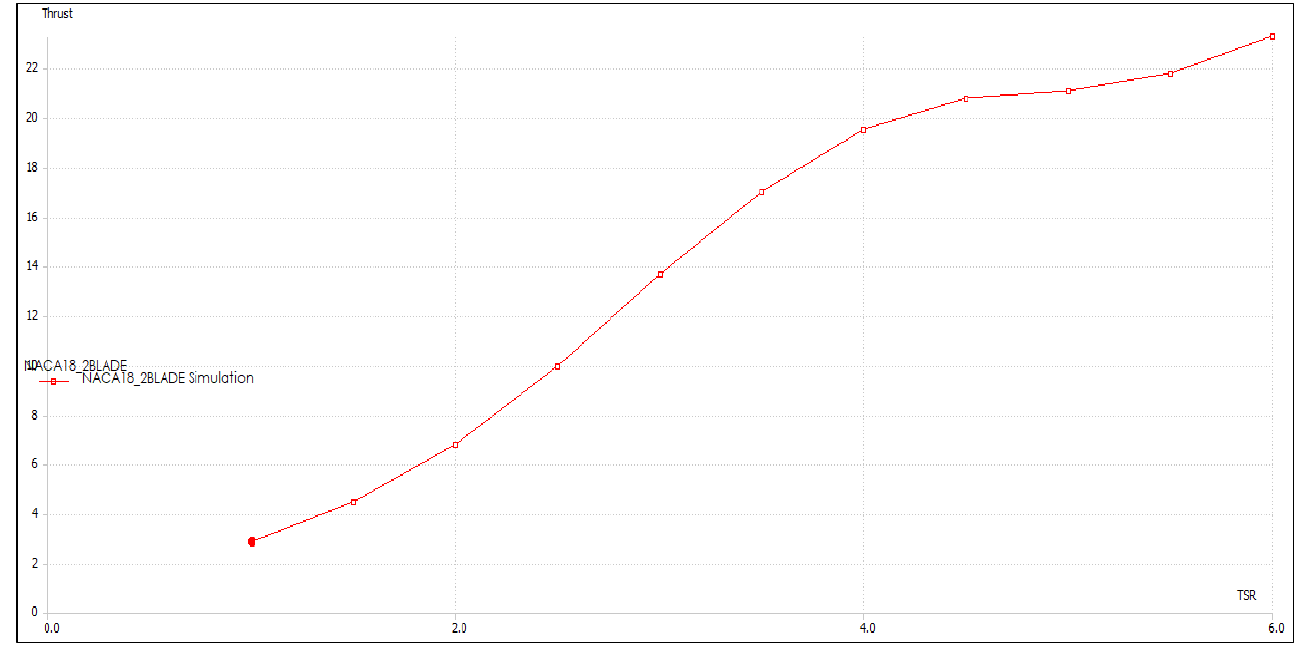
Figure 22. Thrust vs TSR for 2 Bladed